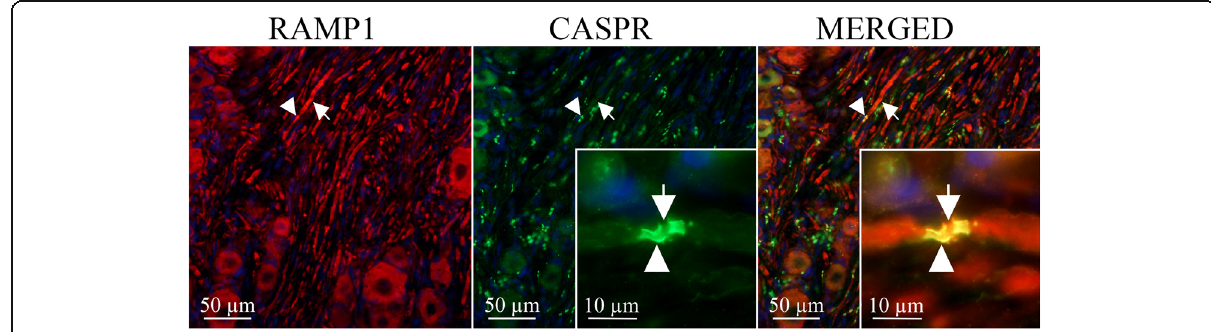
Fig. 2 CGRP receptor localization at the paranodal region in the TGImmunohistochemical localization of the CGRP receptor protein RAMP1 (red, arrow) in myelinated axons of the trigeminal ganglion labeled with CASPR (green, arrowhead), a marker for nodes of Ranvier. Merged images reveal co-localization (yellow) of RAMP1 with CASPR at the